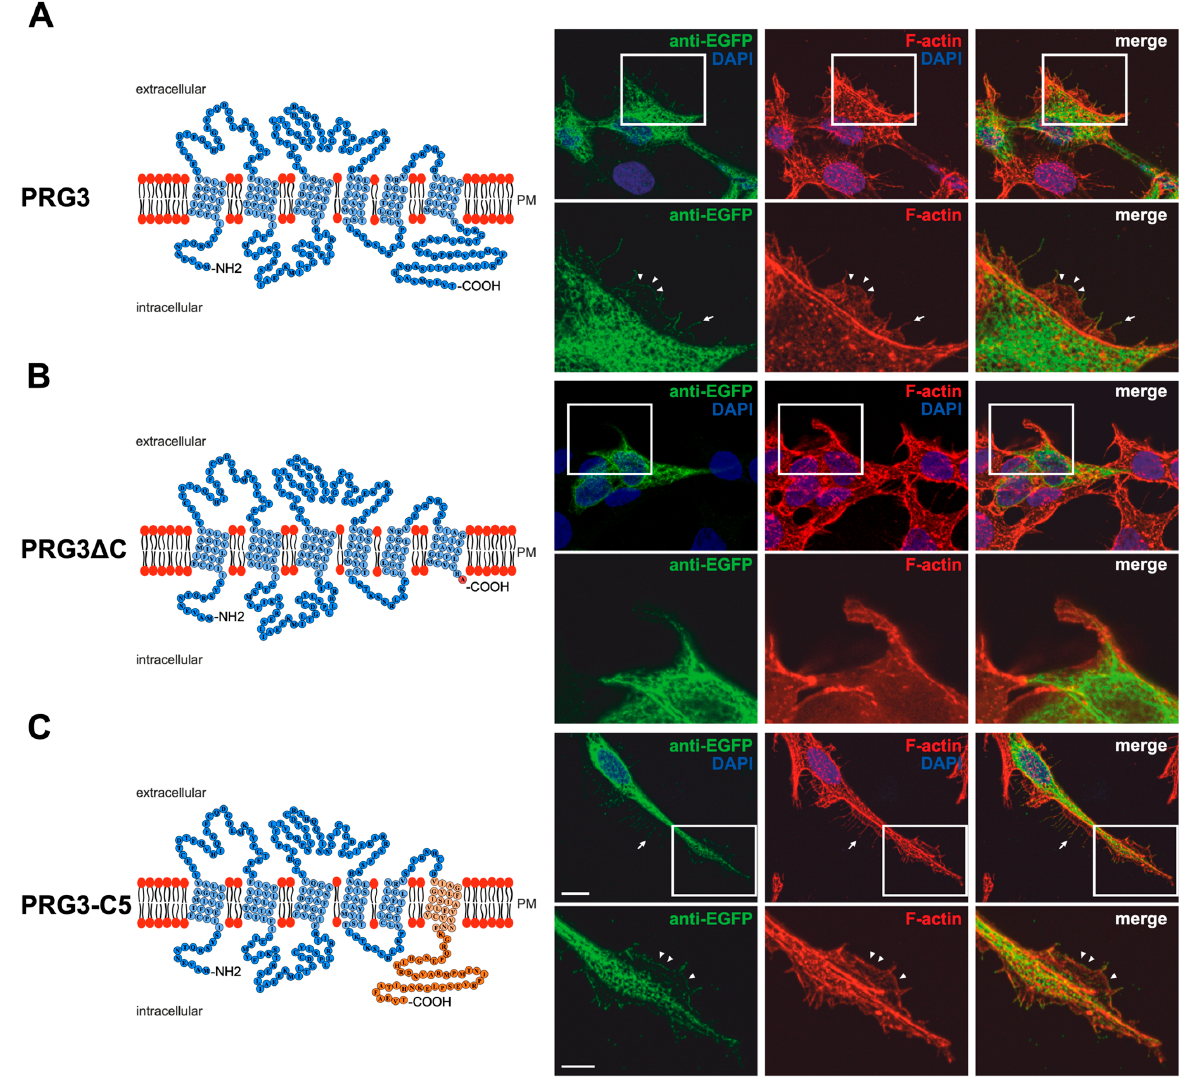
Figure 1. PRG3 and PRG5 C-terminal domains are essential for inducing morphological changes in non-neuronal cells ( A ) Left panel: Schematic depiction of PRG3. Transmembrane domains TM1-TM6 are highlighted in light blue and the C- and N-terminal regions are located on the intracellular side. Single circles represent amino acids (aa) (one letter code). Right upper panel: Confocal stacks of representative HEK293H cells transfected with PRG3-EGFP fusion-encoding plasmids and stained for GFP. Arrows point to filopodia identified by F-actin staining (red, phalloidin). Arrowheads denote areas showing membrane localization. This refers also to (C). PM = plasma membrane. Right lower panel: Higher magnification of representative HEK293H cells transfected as indicated above and shown by white rectangles. ( B ) Left panel: Schematic depiction of PRG3 ∆ C (43 aa deleted). Upper right panel: Confocal stacks of representative HEK293H cells transfected with PRG3 ∆ C-encoding plasmids and stained for GFP (green fluorescent protein). Lower right panel: Higher magnification of representative HEK293H cells transfected as indicated above and shown by white rectangles. ( C ) Left panel: Schematic depiction of PRG3-C5. The sequence of exchanged C-terminal domain residues of PRG5 is shown in orange (aa 252–316). Upper right panel: Confocal stacks of representative HEK293H cells transfected with PRG3-C5-encoding plasmids and stained for GFP. Lower right panel: Higher magnification of representative HEK293H cells transfected as above and indicated by white rectangles. Cell nuclei were stained with DAPI (blue). The scale bar represents 10 µ m in the upper panels and 5 µ m in the lower